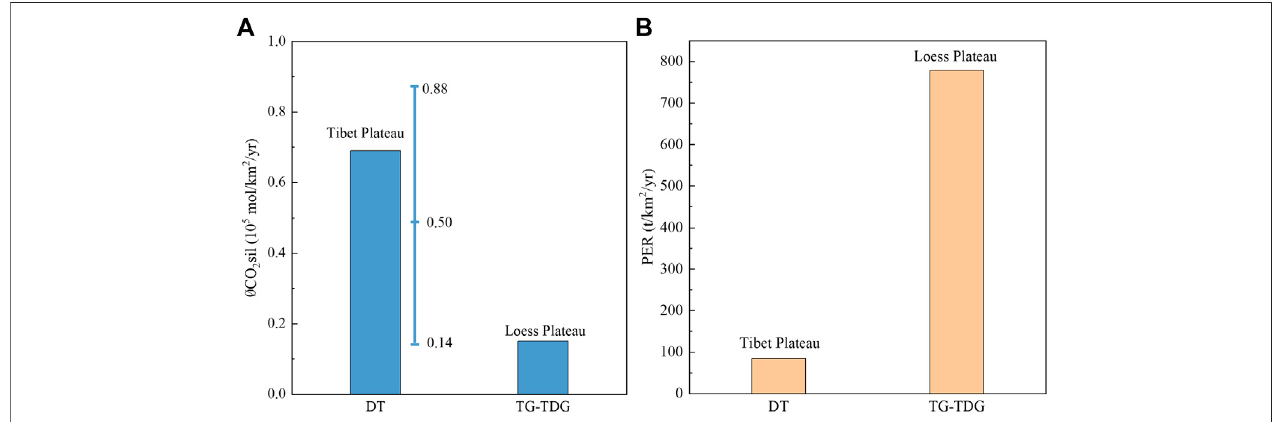
FIGURE11 | Differences in (A) weathering and (B) erosion rates between the TibetPlateau and LoessPlateau. The ØCO 2 sil (0.69 × 10 5 mol/km 2 /yr)calculated by thetime-seriesdataoftheDatongRiver(DT)iswithintherange ofspatial data(0.14 – 0.88×10 5 mol/km 2 /yr)atupper reachesoftheYellowRiver.Themaximumvalueof theØCO 2 silintheTibetPlateauis0.88(atLanzhoufromWuetal.,2005),theminimumvalue(atTaoRiverfromWuetal.,2005)is0.14,andtheaveragevalueis0.50;the Loess Plateau data from Tongguan to Toudaoguai (TG-TDG) come from Ran et al. (2015). The physical erosion rate (PER) is estimated by suspended sediment data during 2013 from local hydrological